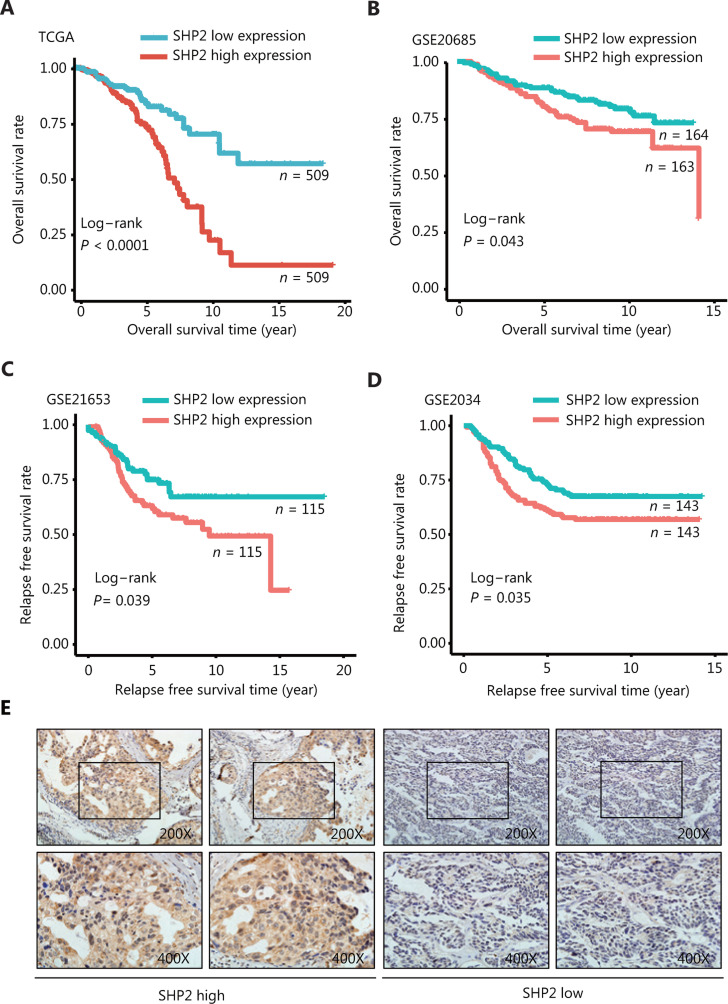
High expression of SHP2 is associated with poor prognosis in patients with breast cancer. (A, B) The overall survival rate in patients with elevated SHP2 expression was significantly poorer than that in patients with low SHP2 expression, on the basis of the TCGA and GSE20685 databases (P < 0.001 and P = 0.043, respectively). (C, D) The relapse-free survival rate in patients with elevated SHP2 expression was significantly poorer than that in patients with low SHP2 expression, on the basis of the GSE21653 and the GSE2034 databases (P = 0.039 and P = 0.035, respectively). (E) The expression of SHP2 in breast cancer tissue was detected via IHC staining. The expression of SHP2 was scored according to the stained area and staining intensity, and divided into 2 groups with high and low SHP2 expression.